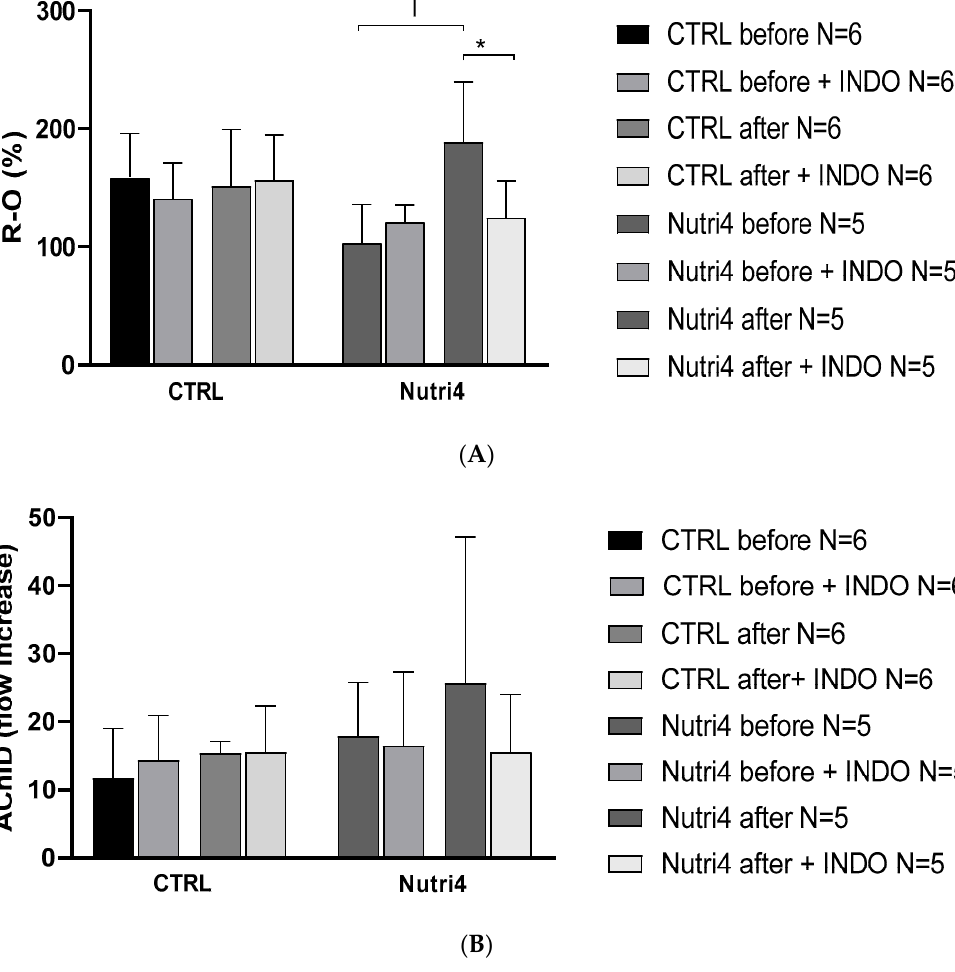
Figure 3. Panel ( A ). Post-occlusive reactive hyperemia (PORH) before and after the dietary protocol with/without administration of indomethacin. This part of the measurements was performed on a separate set of participants, due to measurement design. Results are shown as mean ± standard deviation (SD); * p < 0.05 paired t -test before and after dietary protocol with the administration of indomethacin. † p < 0.05 paired t -test before and after dietary protocol without administration of indomethacin. Panel ( B ). Forearm skin microcirculation by iontophoresis-AChID before and after administration of 100 mg indomethacin. This part of the measurement was performed on a separate set of participants, due to the design of the measurement.